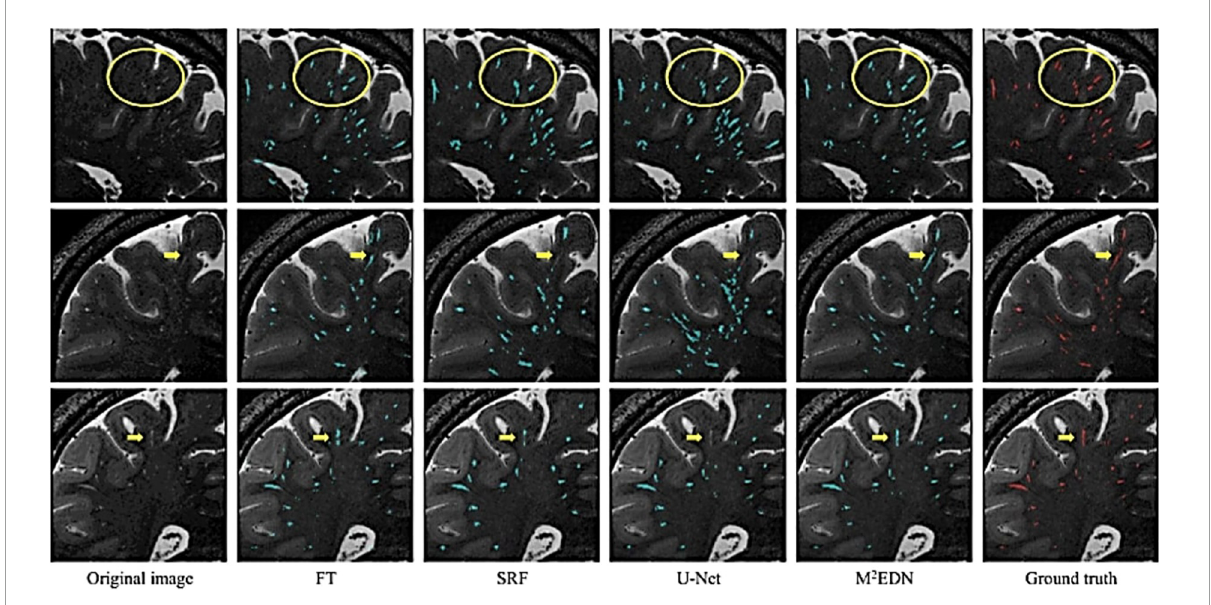
FIGURE7 Visual assessment of predicted PVS segmentations from different algorithms to the ground truth, adapted from Lian et al. (2018). Visual comparisons are used to compare algorithms to each other and the ground truth. Red voxels are PVS that have been manually labeled by a human rater. Cyan voxels were predicted to be PVS by the respective automated method. Yellow arrows and circles indicate low contrast perivascular spaces that can be used to differentiate segmentation ability of different methods. FT, Frangi filtering; SRF, structured random forest; M 2 EDN, multi-channel, multi-scale encoder-decoder network. Reprinted from Lian et al. (2018), with permission from Elsevier, conveyed through the Copyright Clearance Center,